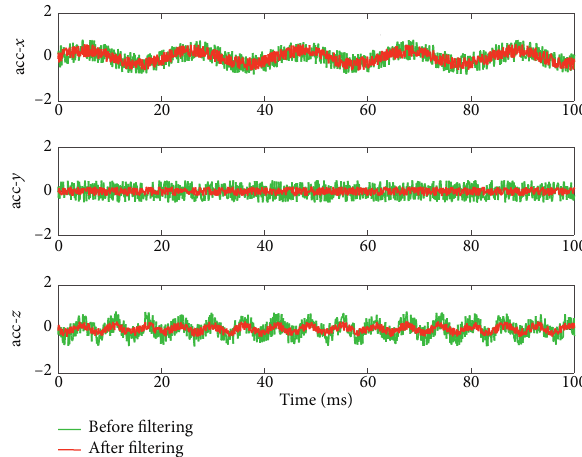
Figure 5: Three-axis acceleration collection results for the elderly at home.